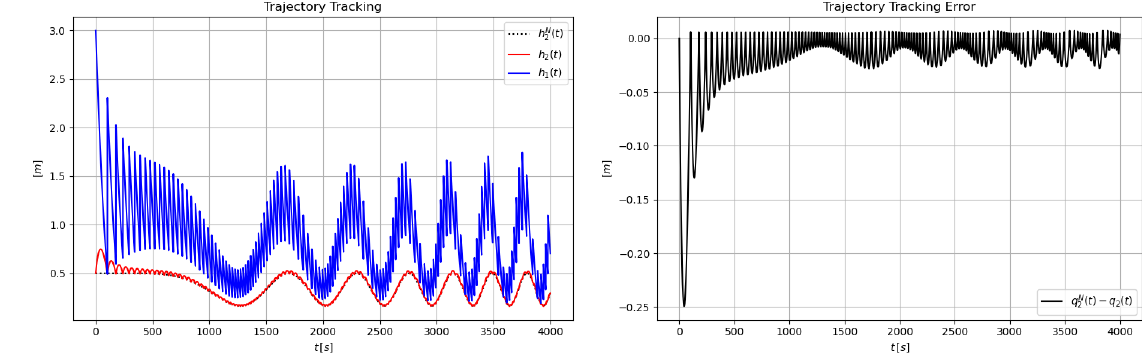
Figure 5. Trajectory tracking and tracking errors without adaptivity.